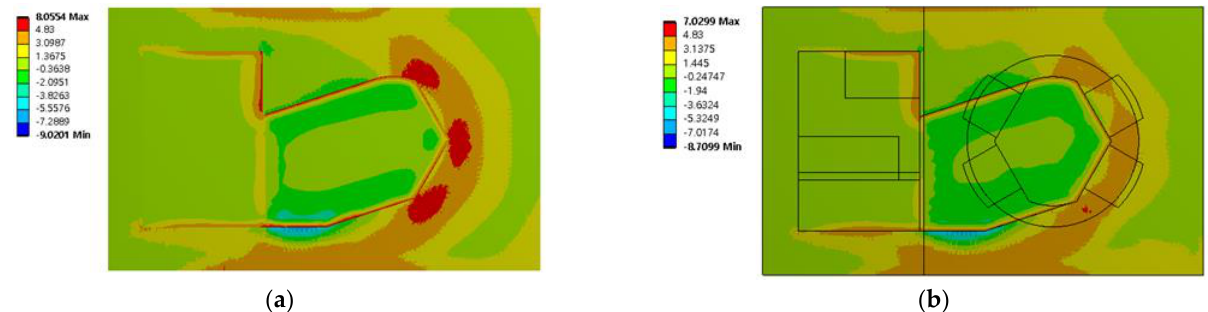
Figure 8. Maximum principal stress distribution in the concrete walls. ( a ) The Drucker-Prager model. ( b ) The Menetrey-William model.